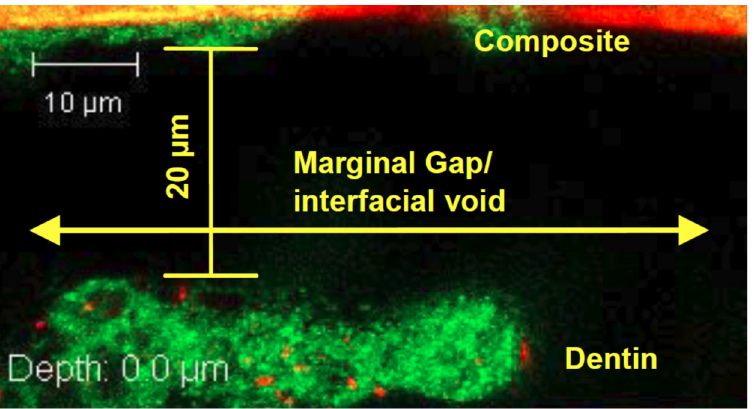
Figure 5. S. mutans biofilm present within the marginal gap between the composite restoration and dentin, as shown by the green-stained biofilm.